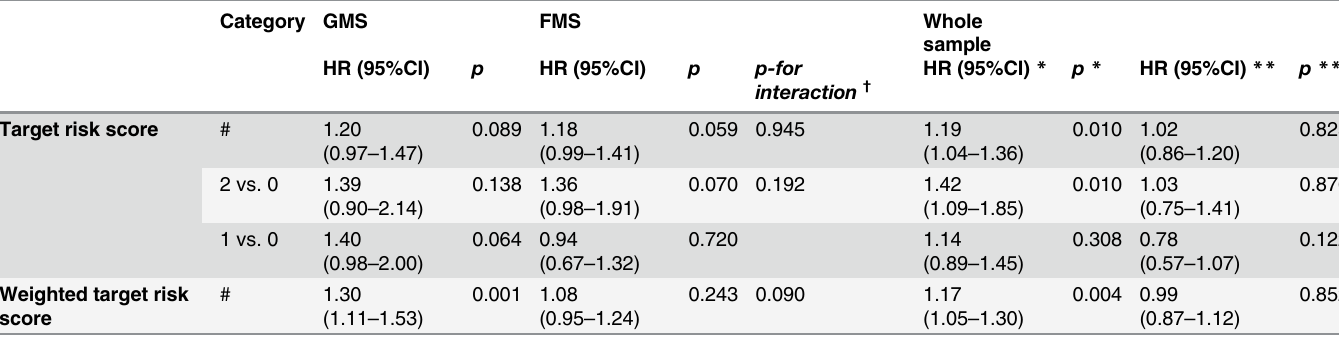
Table 3. Hazard ratios for all-cause mortality of target scores in patients with type 2 diabetes of GMS, FMS and whole sample.